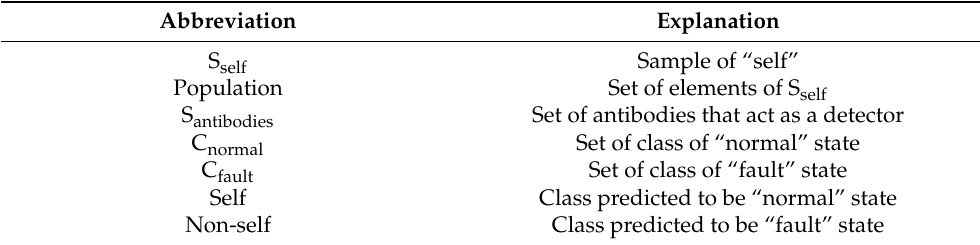
Table 1. Explanation of abbreviations used in pseudo